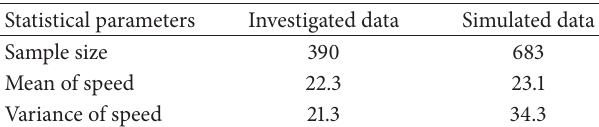
Table 2: Comparison of the investigated values and simulation